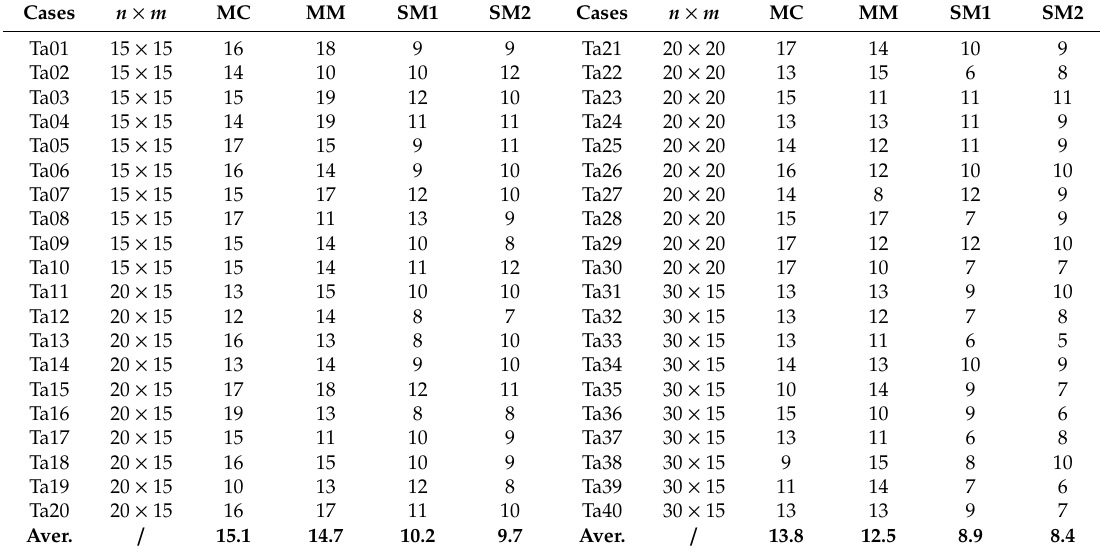
Table 6. The values of N µ for the algorithms MC, MM, SM1, and SM2 in the problem set